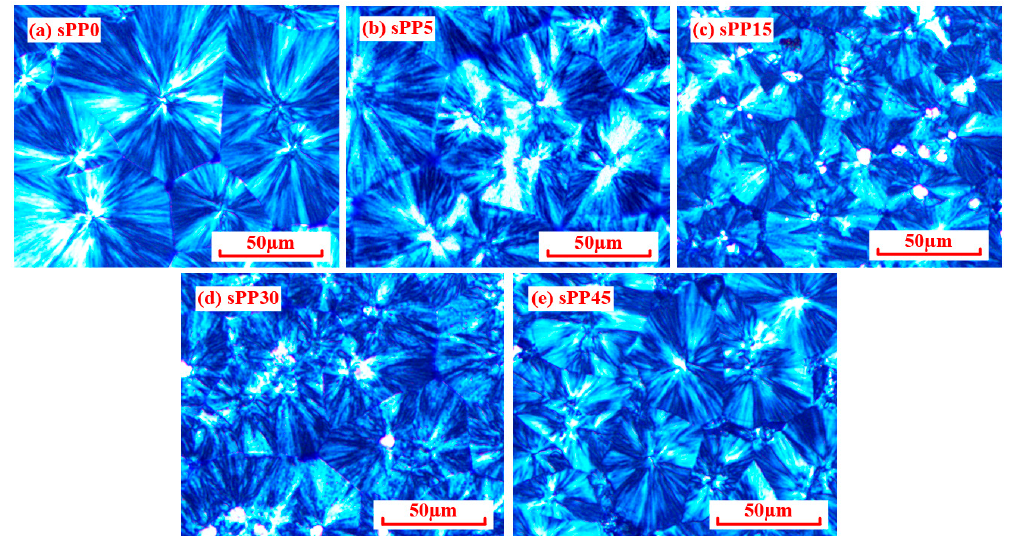
Figure 8. Crystal morphology of iPP/sPP blends. ( a ) sPP0, ( b ) sPP5, ( c ) sPP15, ( d ) sPP30, ( e ) sPP45.